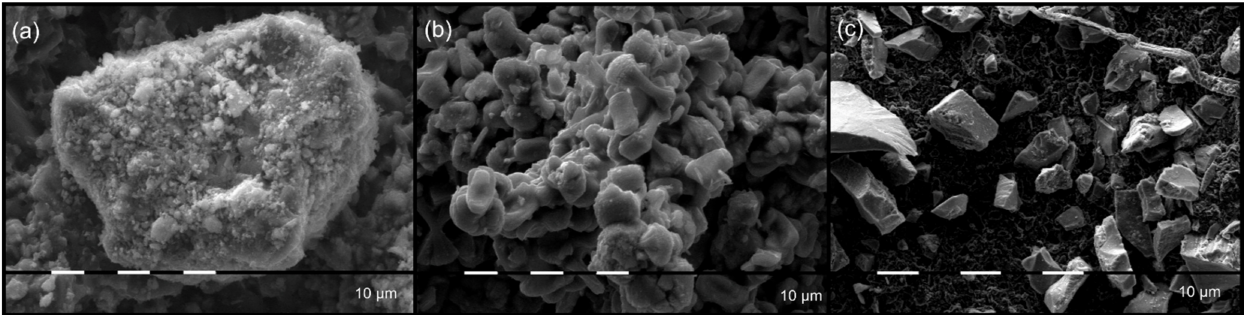
Figure 2. SEM images of ( a ) CPT, ( b ) Na-K-ETS-4, and ( c ) Na-K-GTS-1; magnification is ×